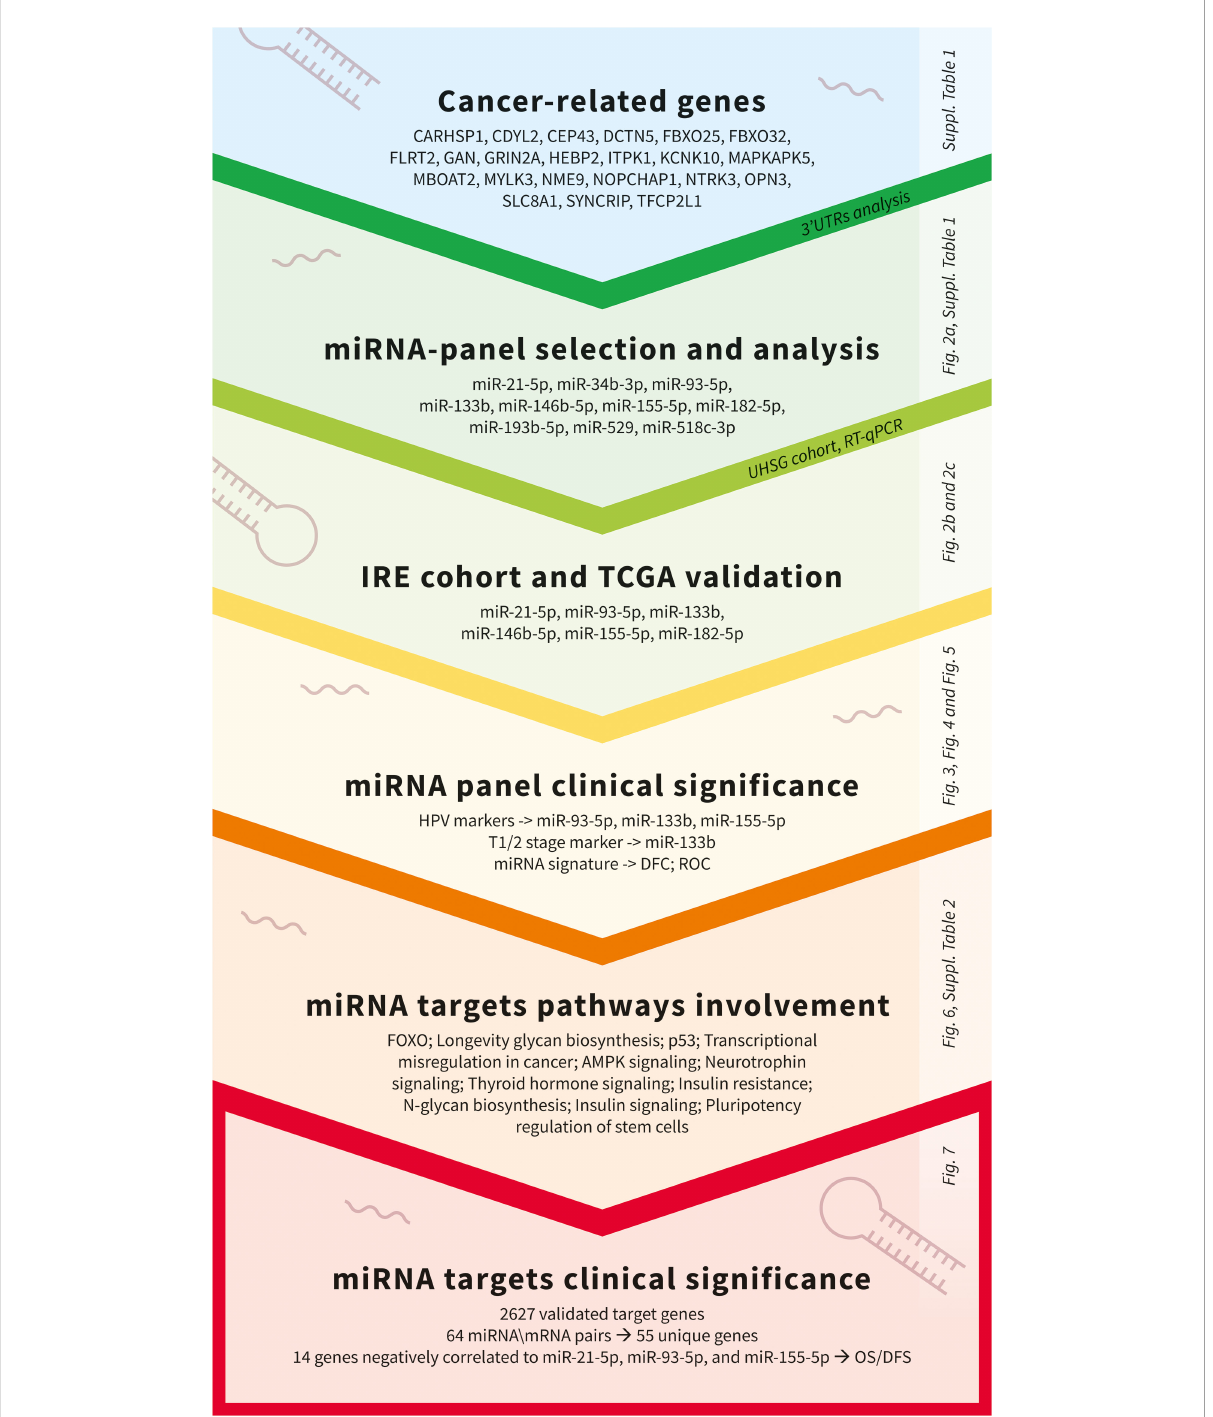
FIGURE 1 Experimental work fl ow used for the identi fi cation of clinically signi fi cant miRNAs and associated targets in